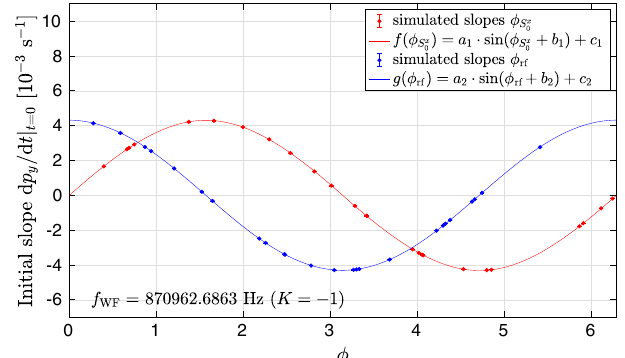
FIG. 10. Panel (a): Definition of the in-plane initial spin orientation angle ϕ inclination angle α ð t Þ .